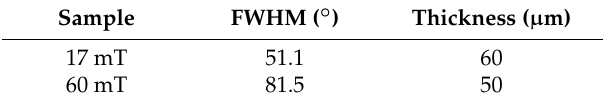
Table 1. Comparison of FWHM and thickness between two polymerized membranes with